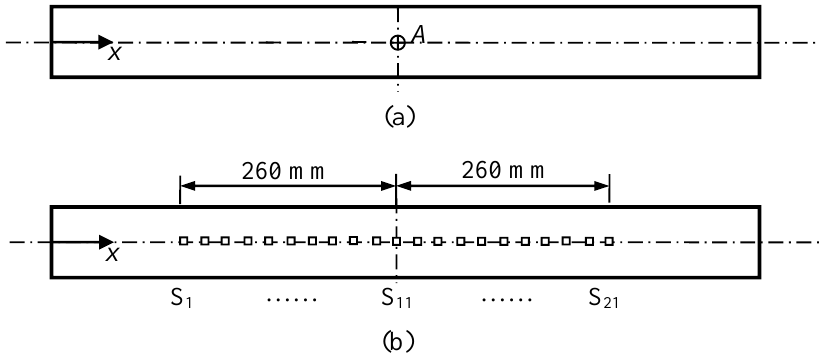
Figure 3. The experimental setup: ( a ) schematic diagram; ( b ) practical setup.